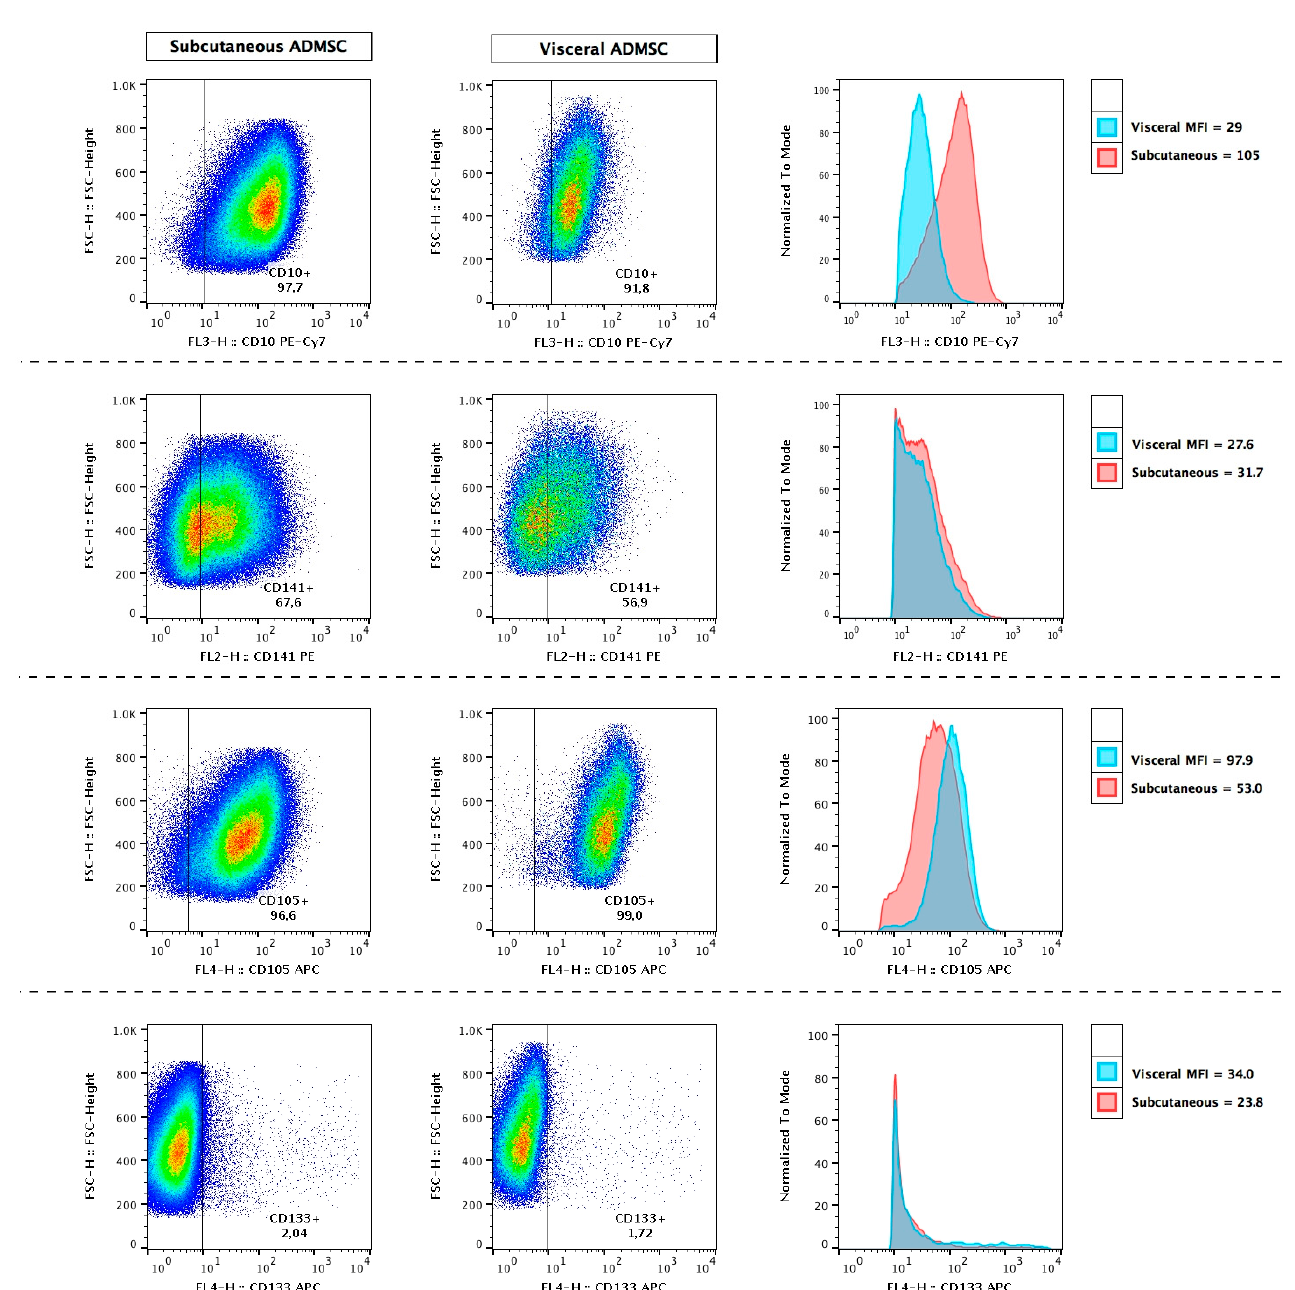
Figure 2. Immunophenotypic characterisation of subcutaneous and visceral ADMSCs in passage 3. Cells were stained and characterised based on CD10+, CD105+, CD133+ and CD141+ markers using flow cytometry. Numbers indicate the percentage of stained cells in the population.